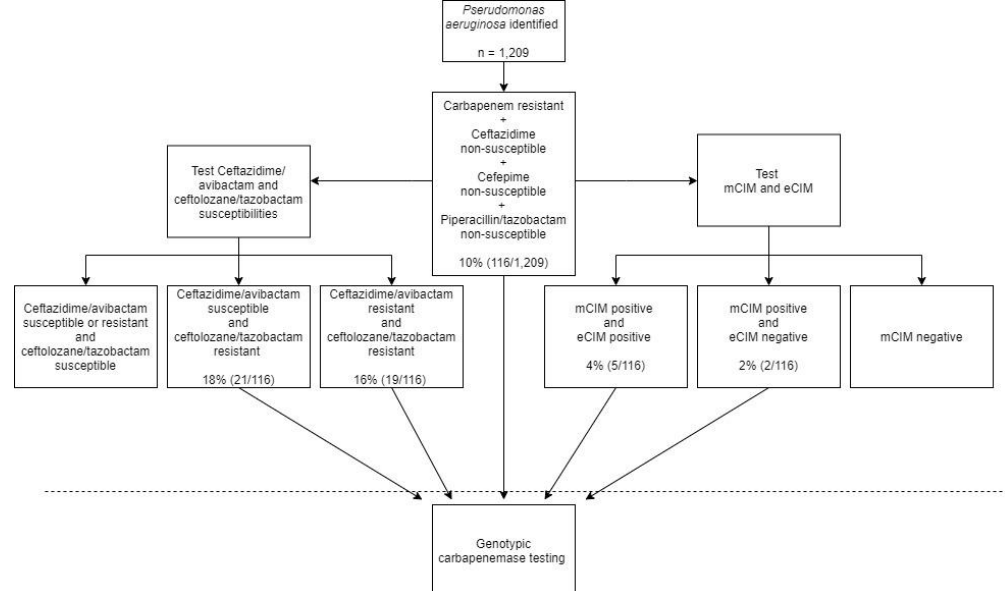
Figure 1. Algorithm for carbapenemase detection in Pseudomonas aeruginosa . The percent (number of isolates meeting current criteria / number meeting preceding criteria) refers to application of the algorithm to the surveillance program evaluated. mCIM, modified-carbapenem inactivation method; eCIM, EDTA-modified carbapenem inactivation method.